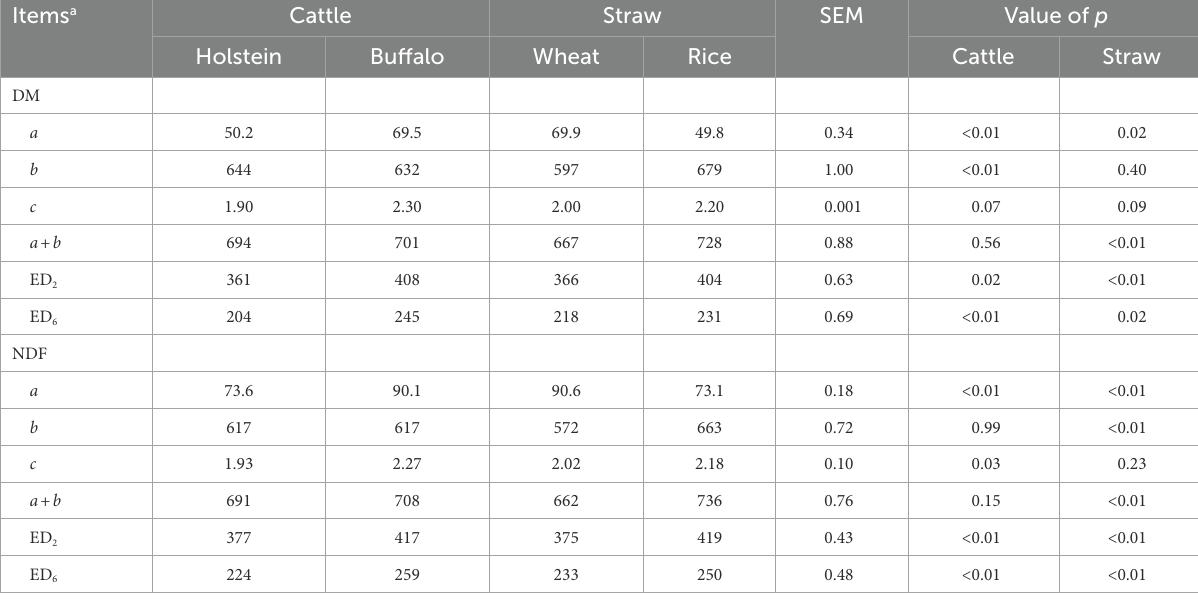
TABLE 2 Characteristics of DM and NDF disappearance of wheat and rice straws after 216 h of in situ ruminal incubation time in buffalo and Holstein rumen. Items a